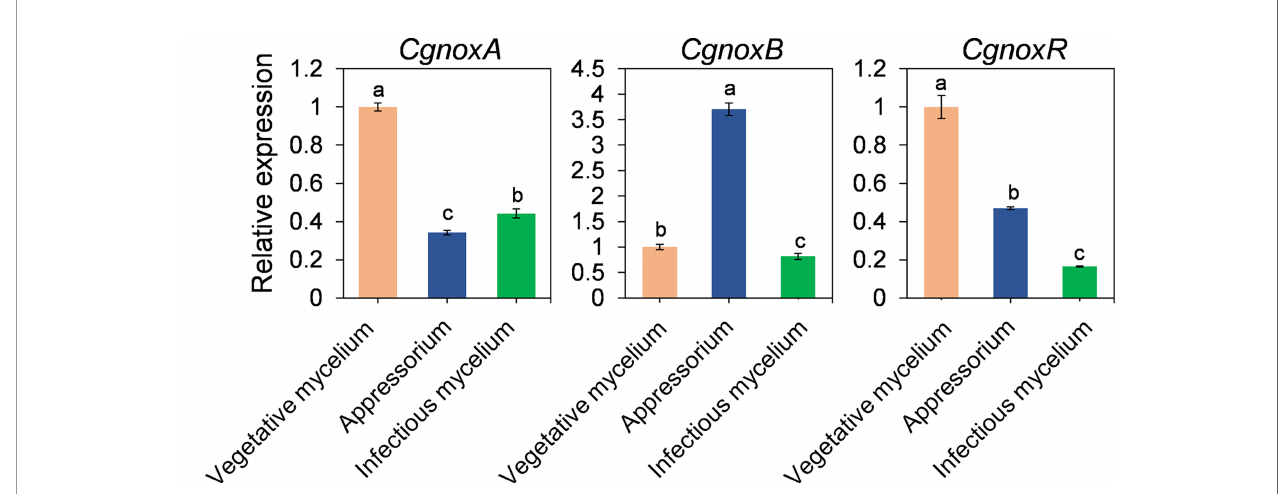
FIGURE 3 | Quantitative RT-PCR of transcript of CgNoxA , CgNoxB , and CgNoxR. Bars represent standard deviations (SD). Columns with different letters indicate signi fi cant difference (p < 0.05).